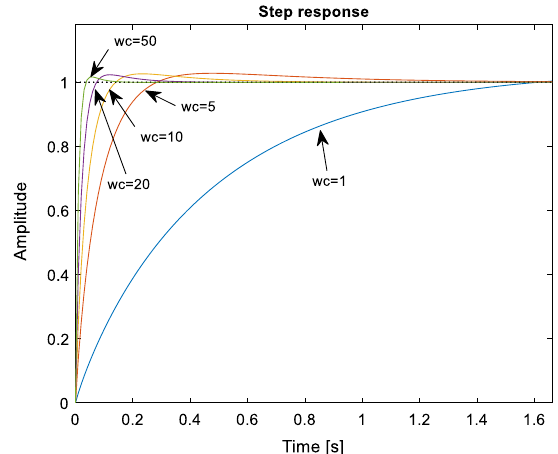
Fig. 40 Step response of the RSC control circuit using FFOADRC